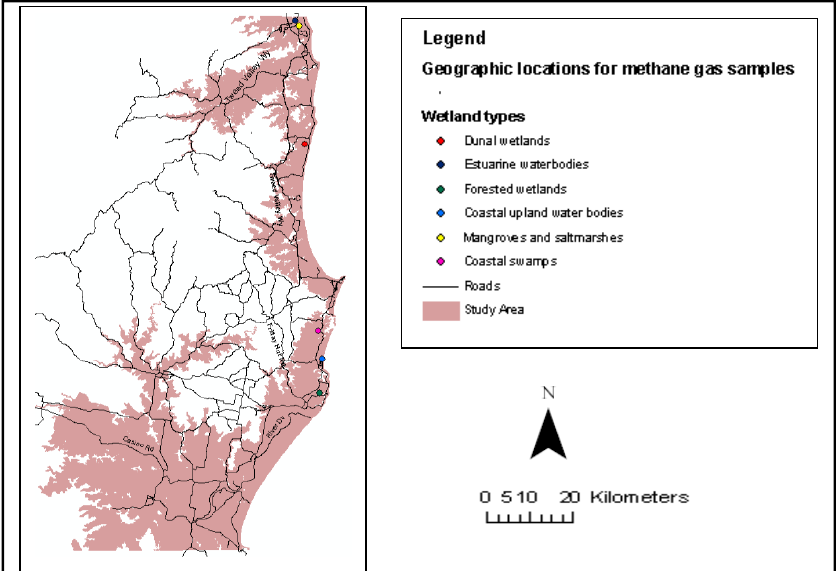
Figure 3. Geographic locations of wetland types for methane gas